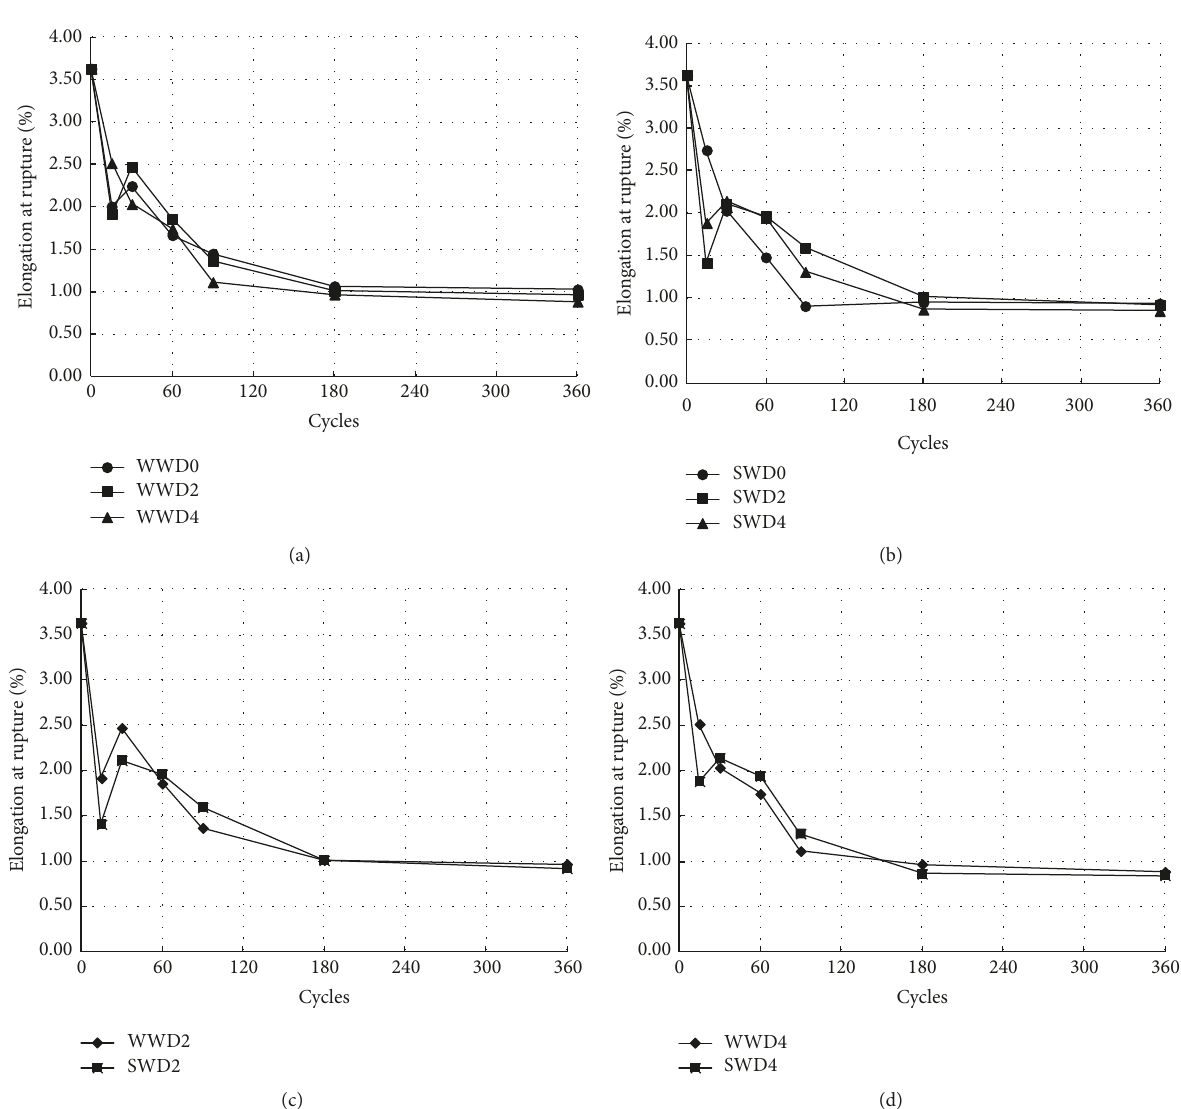
Figure 8: Elongation at rupture of stressed specimens (a) subjected to WD cycles of distilled water and different loads; (b) subjected to WD cycles of saltwater and different loads; (c) subjected to WD cycles and 20% ultimate tensile strength; (d) subjected to WD cycles and 40% ultimate tensile